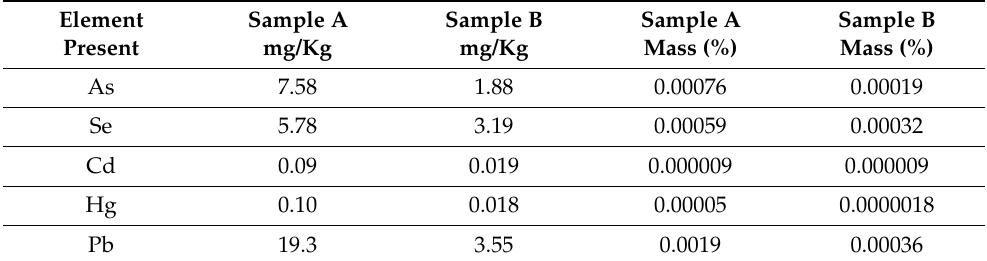
Table 2. ICP-MS elemental